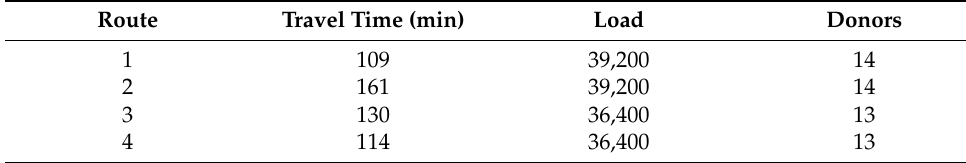
Table 1. Considered features.